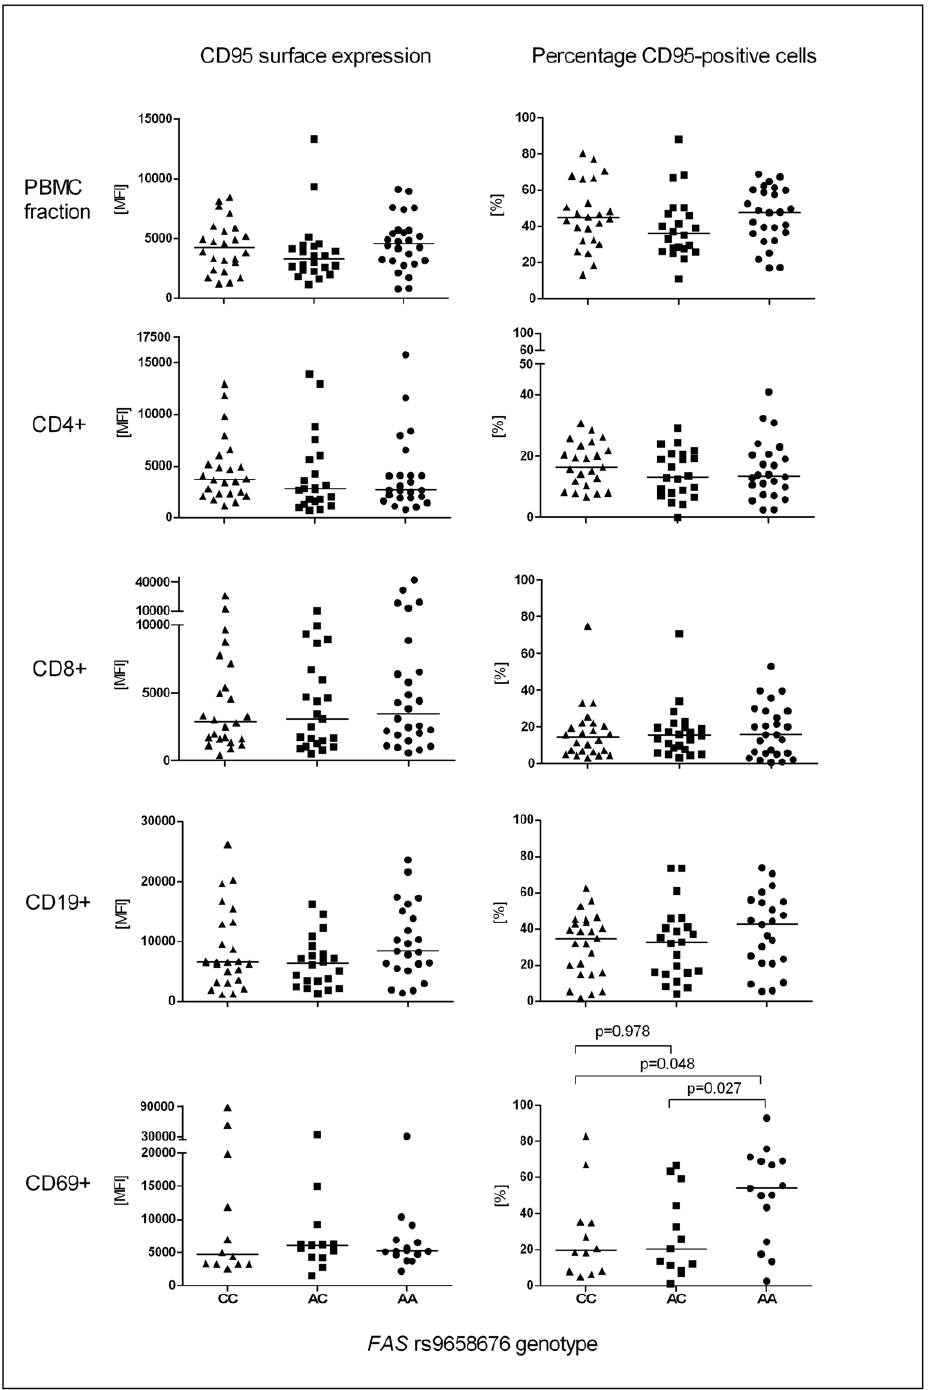
Figure 3. FAS c. 2 436C . A dependent surface expression of CD95 on peripheral blood mononuclear cells. CD95 surface expression was determined in the entire PBMC fraction as well as on CD4 + , CD8 + , CD19 + , and CD69 + cells from PBMCs of 72 healthy Ghanaian donors. Plots on the left show the median fluorescence intensity (MFI), plots on the right represent the mean percentage of CD95 + cells in each fraction of the donors stratified by c. 2 436C . A genotype. Horizontal lines indicate the median for each group. underlying the c. 2 436C . A association presumably affects the cohort, c. 2 436C . A was not associated with differences in the frequency of mild malaria episodes either, although the latter pathogenesis of the severe forms of malaria. It appears most likely to finding has to be interpreted with caution because of a moderate assume that an increased expression of CD95 associated with power to detect significant differences. Nevertheless, the mechanism c. 2 436AA and possibly c. 2 436CA facilitates the programmed cell